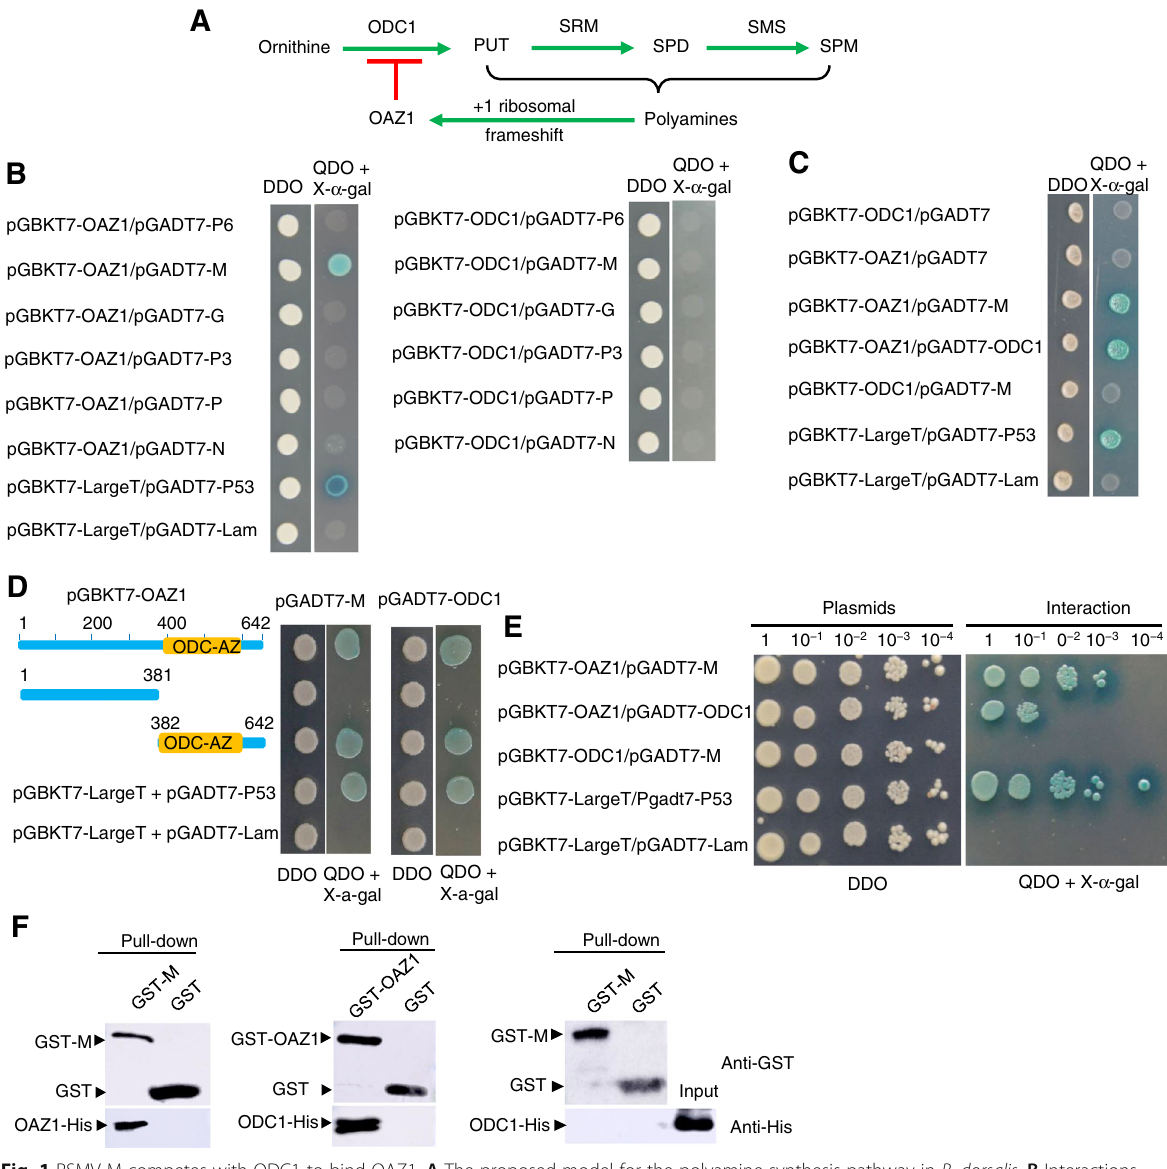
Fig. 1 RSMV M competes with ODC1 to bind OAZ1. A The proposed model for the polyamine synthesis pathway in R. dorsalis . B Interactions among M, N, P, G, P3 or P6 of RSMV and ODC1 or OAZ1 of R. dorsalis were detected by yeast two-hybrid assay. Transformants on plates of DDO and QDO + X- α -gal were shown. C Interactions among RSMV M, OAZ1 and ODC1 were detected by yeast two-hybrid assay. Transformants on plates of DDO and QDO + X- α -gal were shown. D The ODC-AZ domain of OAZ1 interacted with RSMV M and ODC1, as detected by yeast two- hybrid assay. E The competitive interactions among RSMV M, OAZ1 and ODC1 were detected by a serially-diluted yeast two-hybrid assay. The yeast strain AH109 was co-transformed with pGBKT7-OAZ1/pGADT7, pGBKT7-ODC1/pGADT7, pGBKT7-OAZ1/pGADT7-M, pGBKT7-OAZ1/pGADT7-M or pGBKT7-ODC1/pGADT7-M. pGBKT7-LargeT/pGADT7-P53 was used as the positive control; pGBKT7-LargeT/pGADT7-Lam served as the negative control. After being diluted to 10 − 1 to 10 − 4 , the yeast cells were plated onto DDO or QDO + X- α -gal plates. F GST pull-down assay was used to detect interactions among M, ODC1 and OAZ1. OAZ1 or RSMV M fused with GST served as the bait, and single GST served as the control. OAZ1 or ODC1 fused with His served as the prey. Input and pull-down samples were probed with antibodies against GST or His for western blot